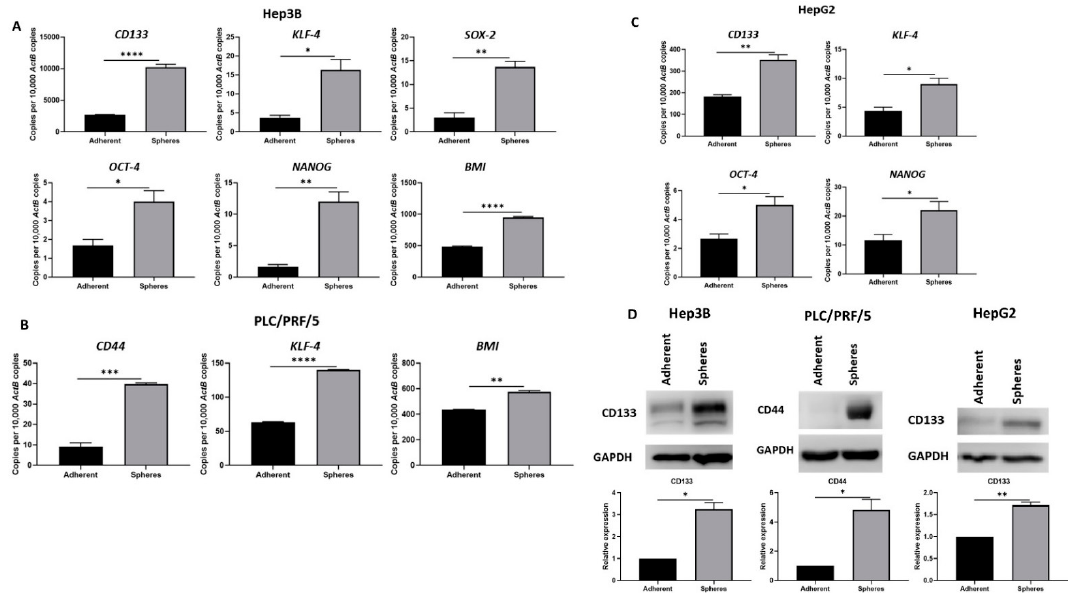
Figure 2. Human HCC-derived spheres exhibit stem-cell-like features. ( A ) qRT-PCR demonstrated upregulation of stem cell markers CD133, KLF-4, SOX-2, OCT-4, NANOG, and BMI in Hep3B-derived spheres compared to adherent Hep3B cells. ( B ) PLC/PRF/5-derived spheres exhibited increased expression of CD44, KLF-4 and BMI compared to adherent cells as shown by qRT-PCR. ( C ) qRT-PCR revealed higher expression of CD133, KLF-4, OCT-4 and NANOG in HepG2-derived spheres compared to parental cells. ( D ) Increased CD133 expression in Hep3B and HepG2-derived spheres and upregulation of CD44 in PLC/PRF/5-derived spheres compared to adherent cells. GAPDH was the loading control. Detailed information about Western Blot can be found at supplementary materials. ( n = 3, * p < 0.05, ** p < 0.01, *** p < 0.005, **** p < 0.001).